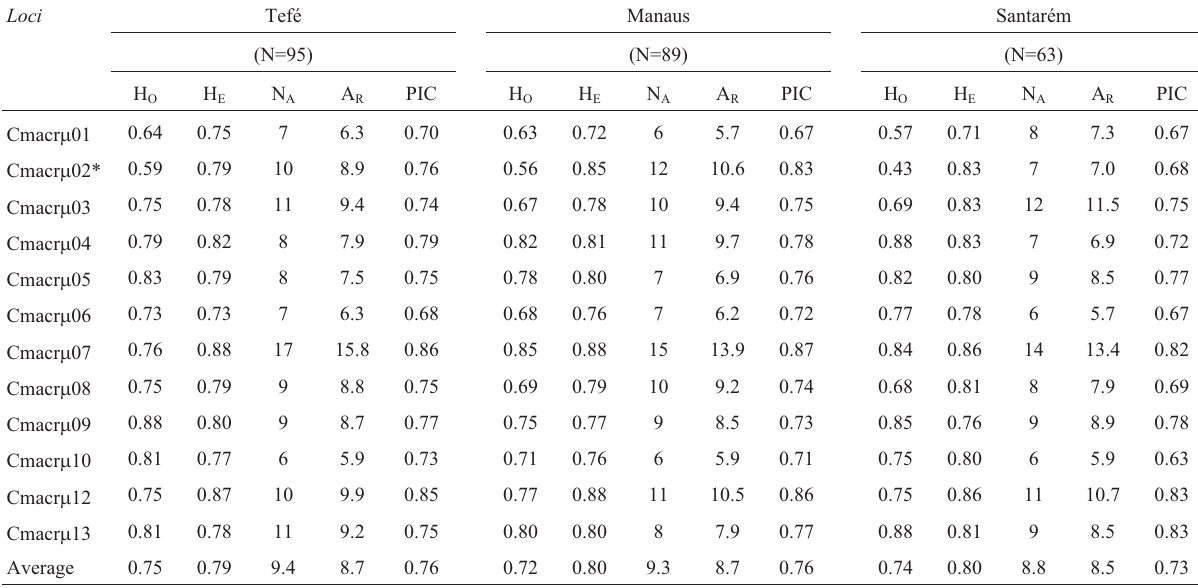
Table 1 - Statistics for individual loci and combined genotype among Colossoma macropomum populations in the Amazon basin. Loci Tefé Manaus